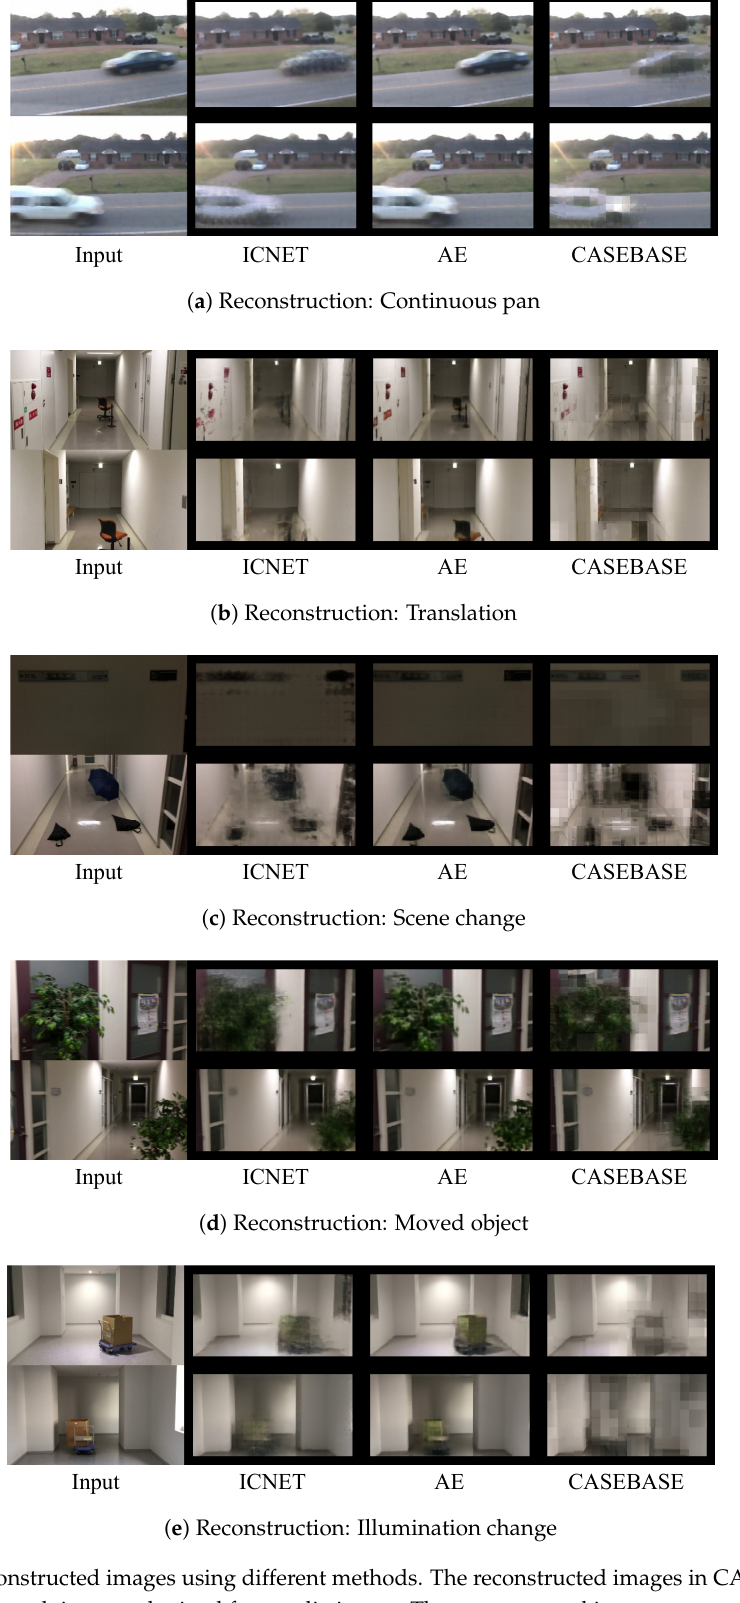
Figure 6. Reconstructed images using different methods. The reconstructed images in CASEBASE are derived from patch images obtained from a dictionary. The reconstructed images were used to obtain the results shown in Figure 5 with the input image (first column), ICNET (second column), AE (third column), and CASEBASE (fourth